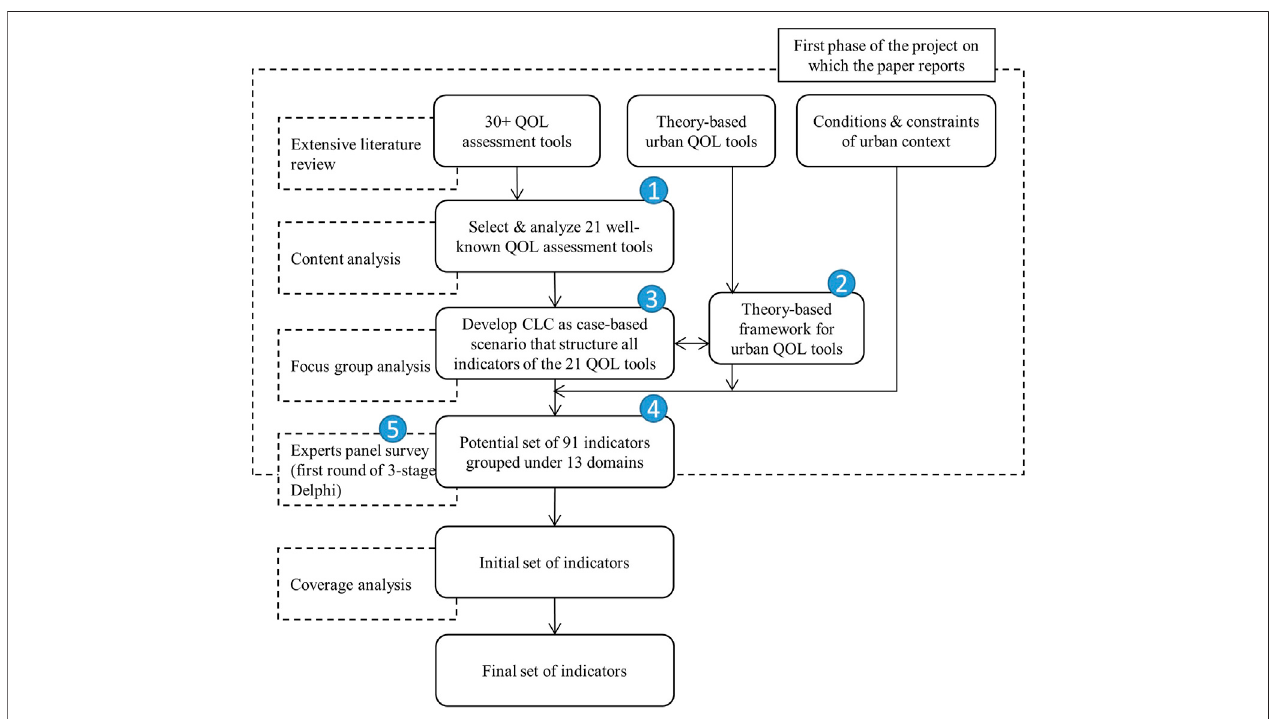
FIGURE 1 | The multi-method research approach of the